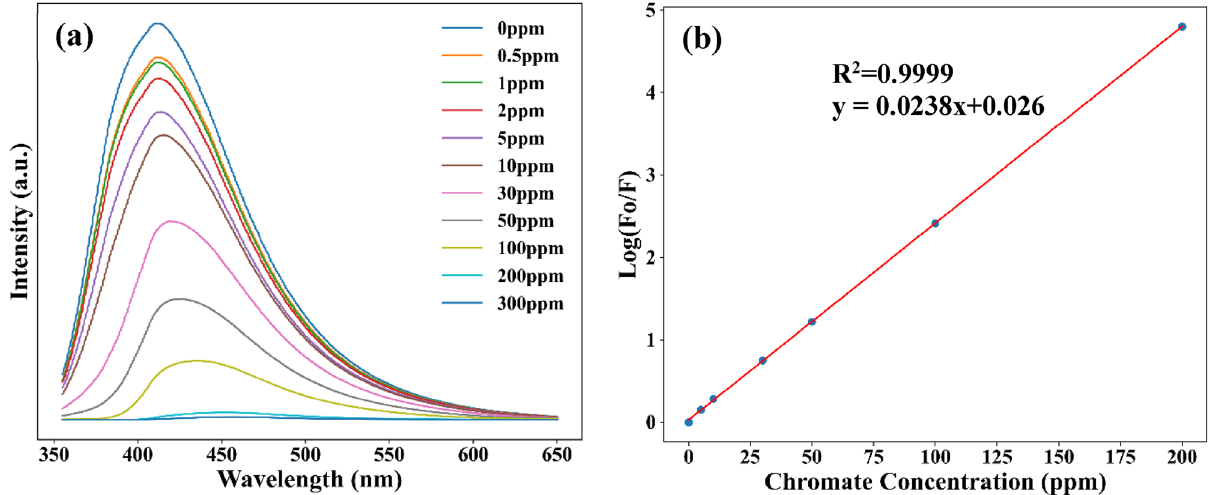
Figure 9. The effect of concentration in the PL intensity of N-10: (a) Stem–Volmer graphs as a function of (log(F 0 /F) versus Cr (VI) concentration (b) .